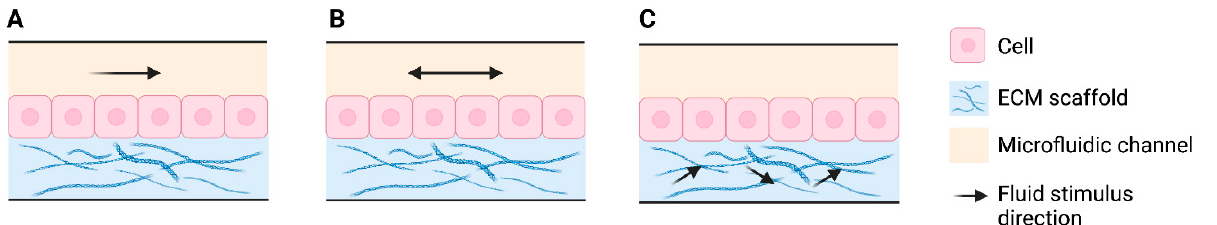
Figure 4. Flow inducing laminar ( A ), pulsatile ( B ), or interstitial ( C ) shear stress. Created with BioRender.com.